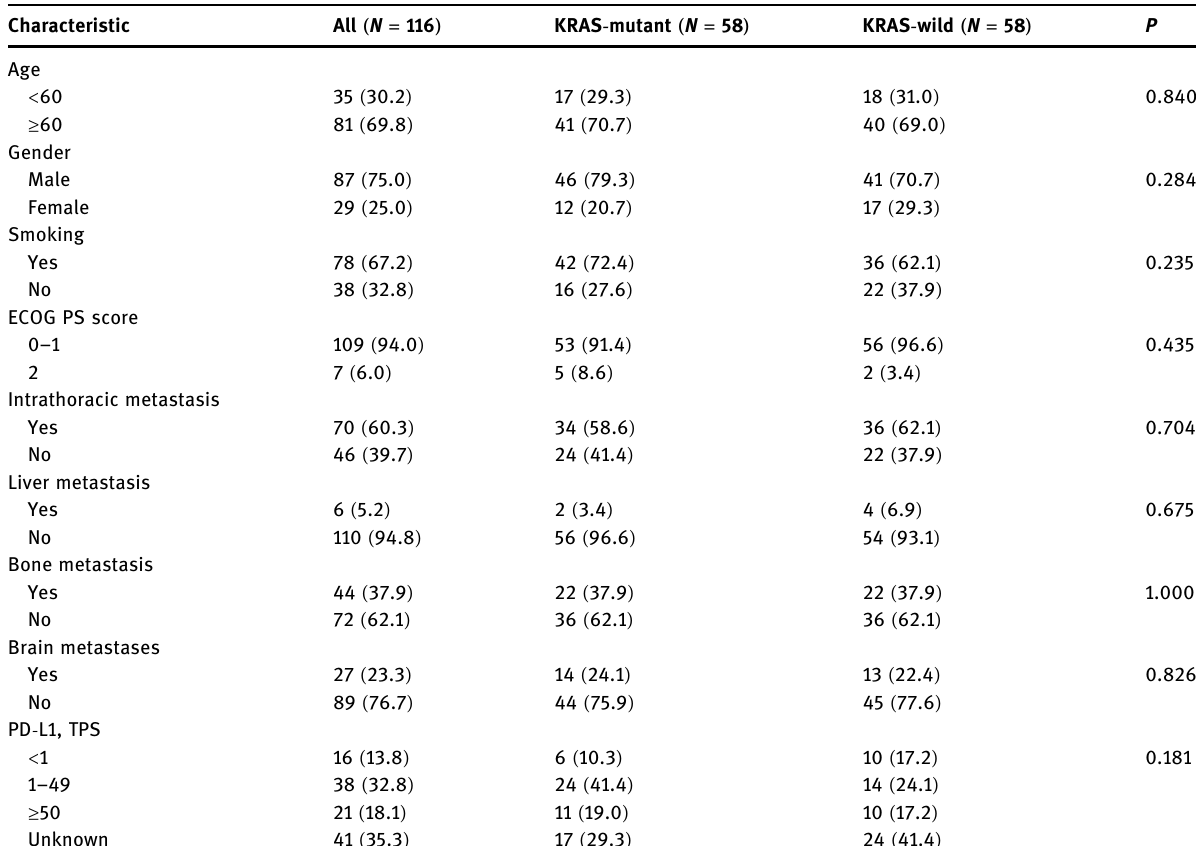
Table 2: Baseline patient characteristics